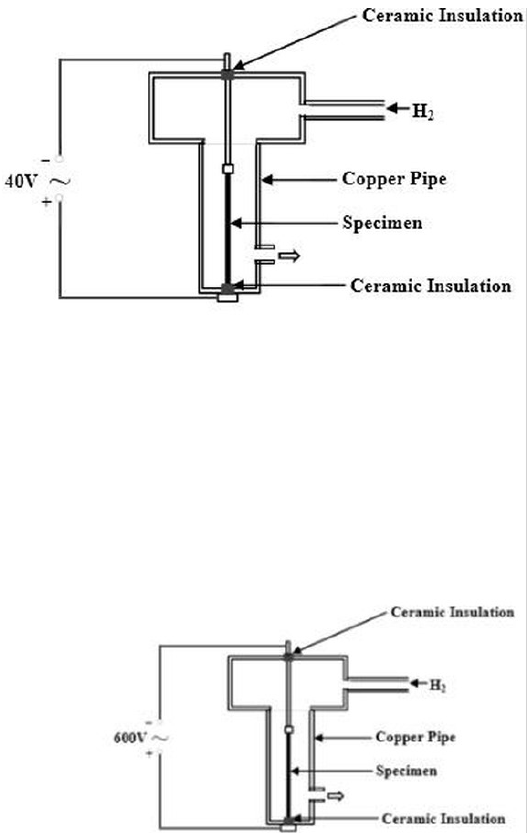
Figure 2. Schematic representation of the experimental setup used for hydrogen plasma charging of the prestressing steel